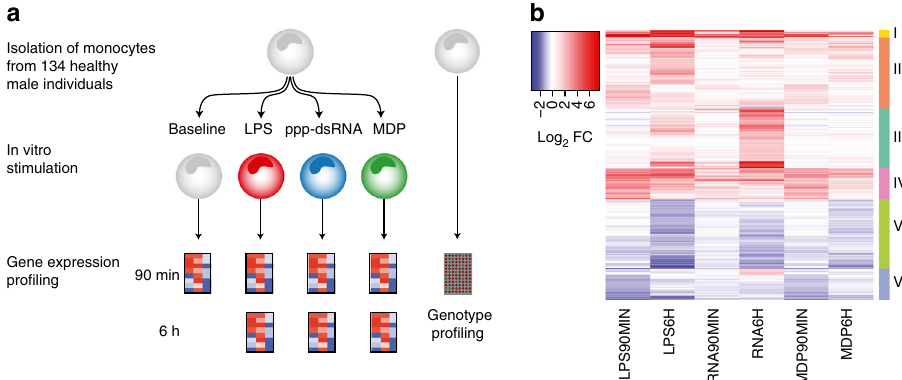
Fig. 1 Overview of the eQTL study and transcriptional immune response in primary human monocytes. a Step-wise experimental design to identify genetic effects on immune response in human monocytes. (1) Isolation and stimulation of primary monocytes from 134 individuals, (2) Transcriptome measurement of the entire cohort at two time points (90 min and 6 h) after stimulation, (3) Genotype pro fi ling to map immune response eQTLs. b Mean mRNA pro fi les of differentially expressed genes (log 2 -fold change > 1, FDR 0.001) of 134 individuals between baseline and each of the six stimulated conditions. Genes are hierarchically clustered into six distinct expression patterns (Supplementary Data 1 for a full list of the differential expression and enriched pathways of each